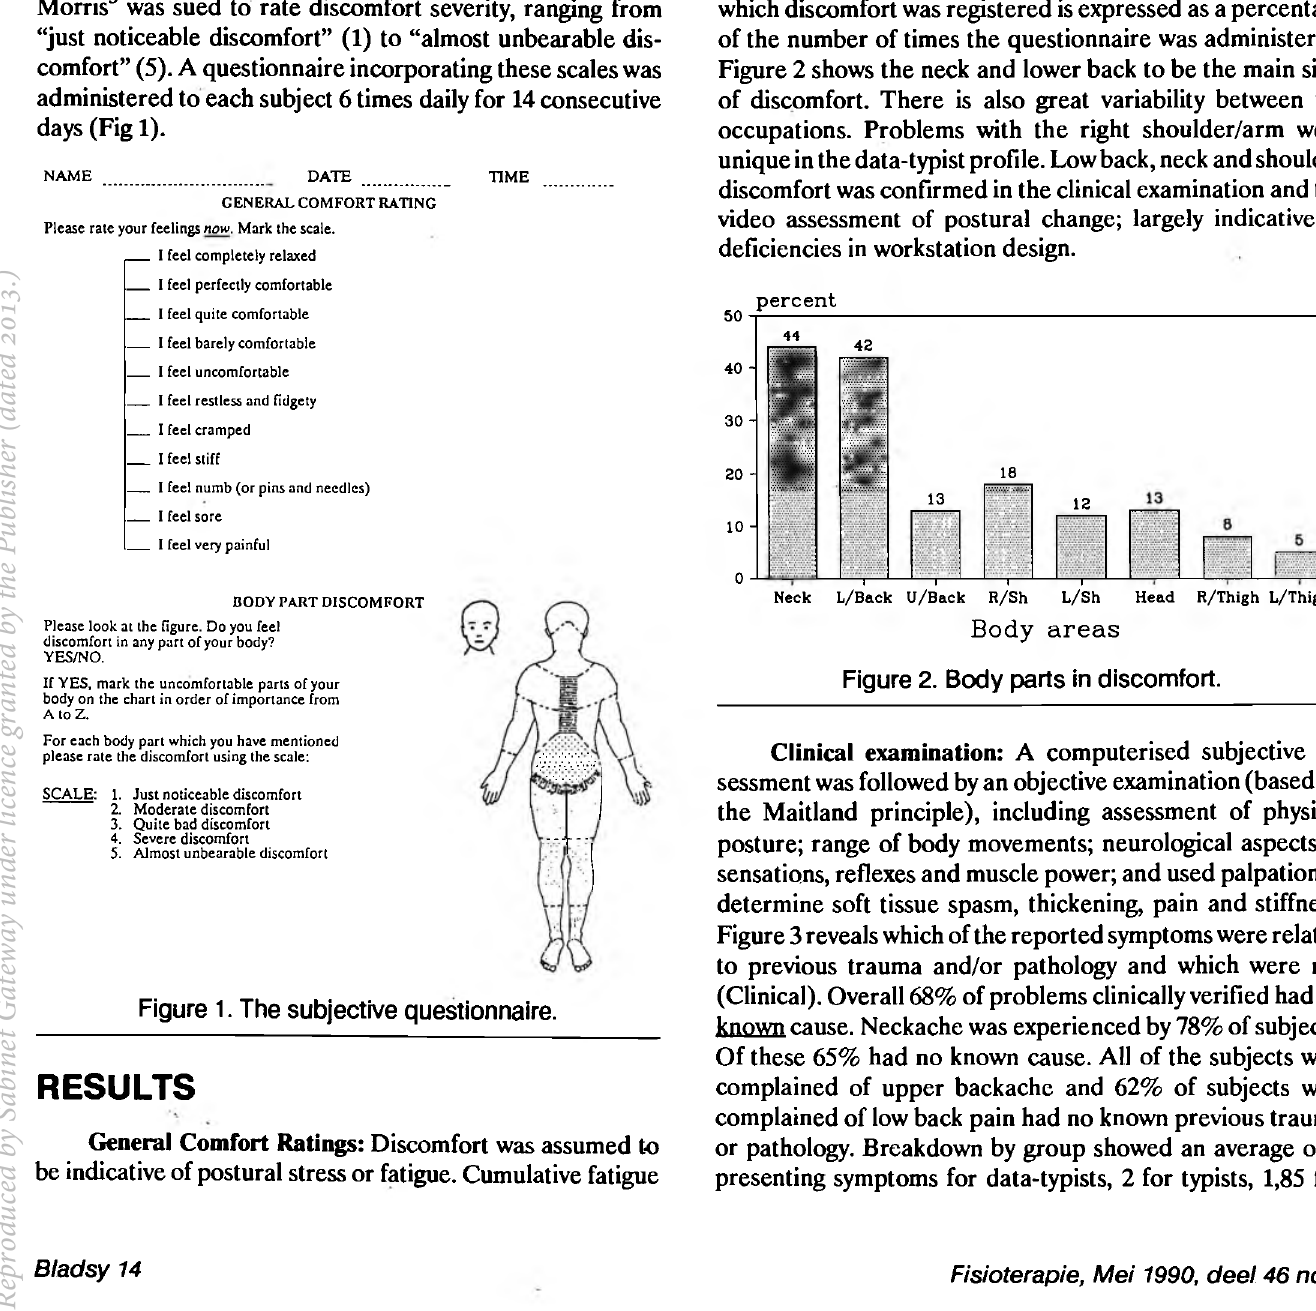
Figure 1. The subjective questionnaire.